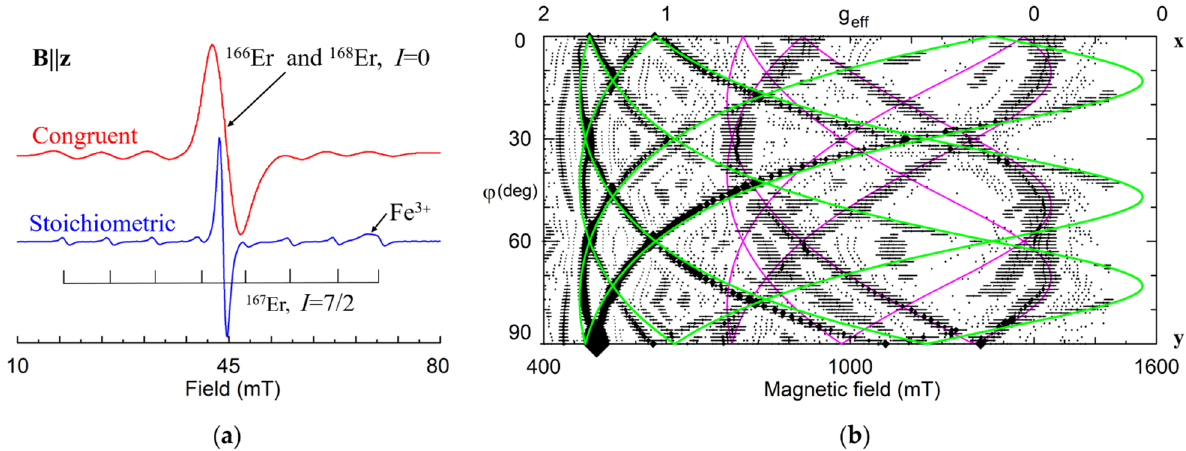
Figure 17. ( a ) EPR spectra of Er 3+ in congruent and stoichiometric LN at B || z , X-band. ( b ) Calculated angular dependence of EPR spectra in xy plane for the Er 13+ (green lines) and Er 23+ (fuchsia lines) centers in sLN. Symbols with horizontal whiskers represent line position and widths.